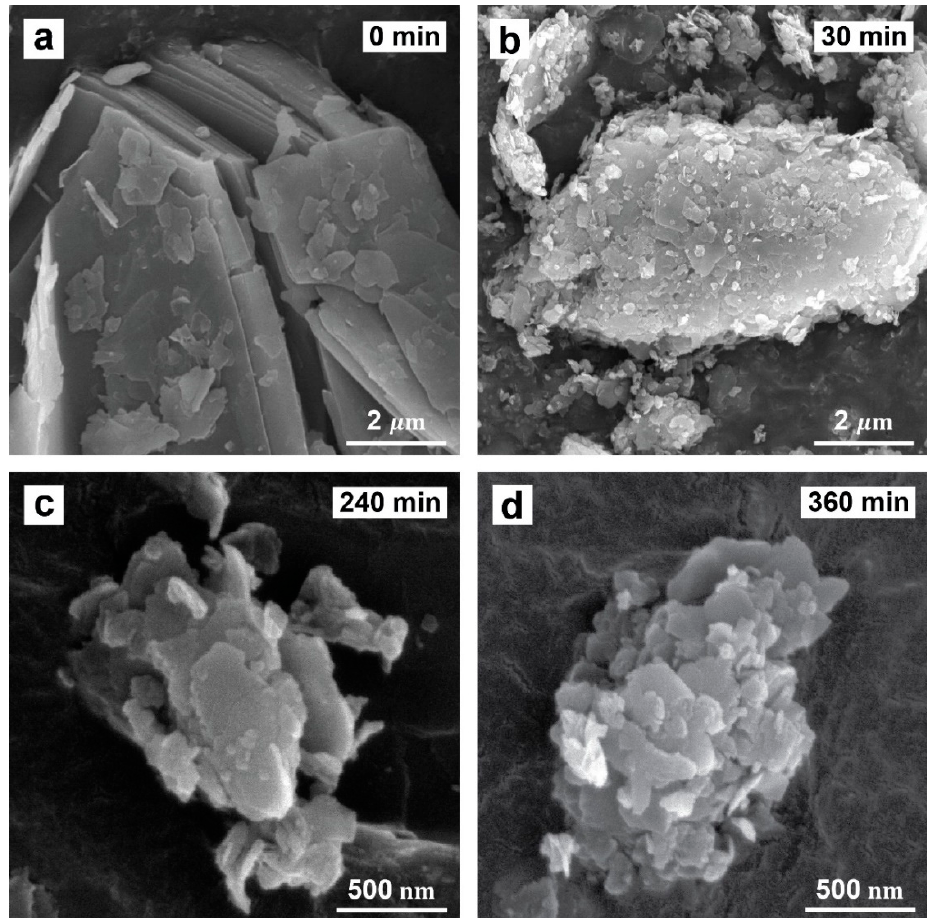
Figure 8. SEM images of ground talc for ( a ) 0 min, ( b ) 30 min, ( c ) 240 min, and ( d ) 360 min using 1 mm balls for high ‐ energy ball milling.